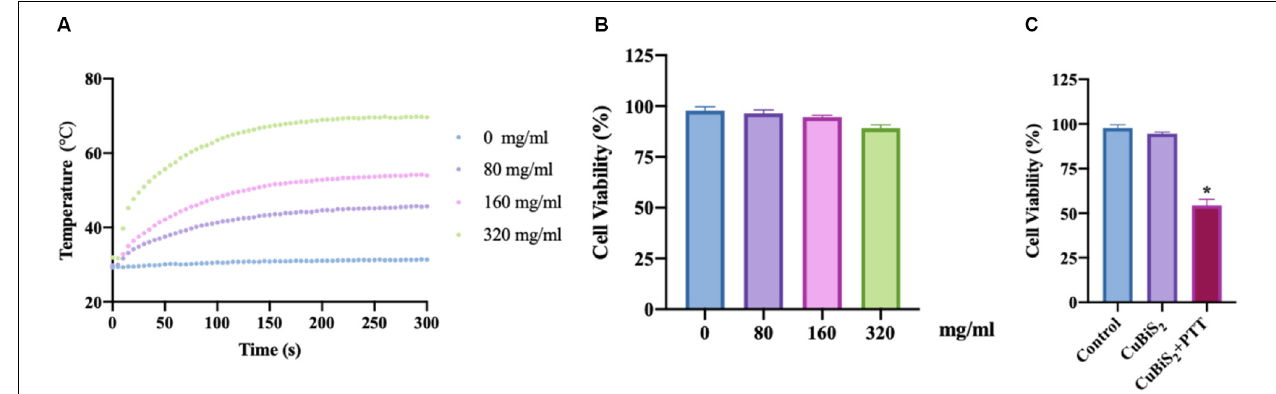
FIGURE 3 | Screening the optimal concentration of CuBiS 2 NPs for photothermal therapy. (A) In vitro photothermal effect of PBS and CuBiS 2 NPs in aqueous solution at different concentrations. (B) Relative cell viabilities of macrophages after co-incubation with CuBiS 2 NPs at different concentrations for 12 h without photothermal therapy. (C) Relative cell viabilities of macrophages after co-incubation with CuBiS 2 NPs at different concentrations for 12 h under photothermal therapy.